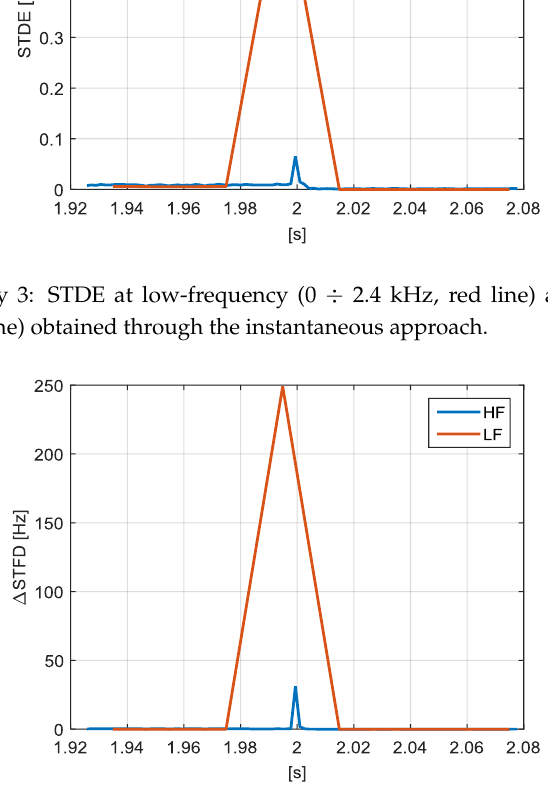
Figure 20. Case study 3: Δ STFD at low-frequency (0 ÷ 2.4 kHz, red line) and at high-frequency (2.4 ÷ 150 kHz, blue line) obtained through the instantaneous approach. Energies 2017 , 10 , 1633 20 of 39